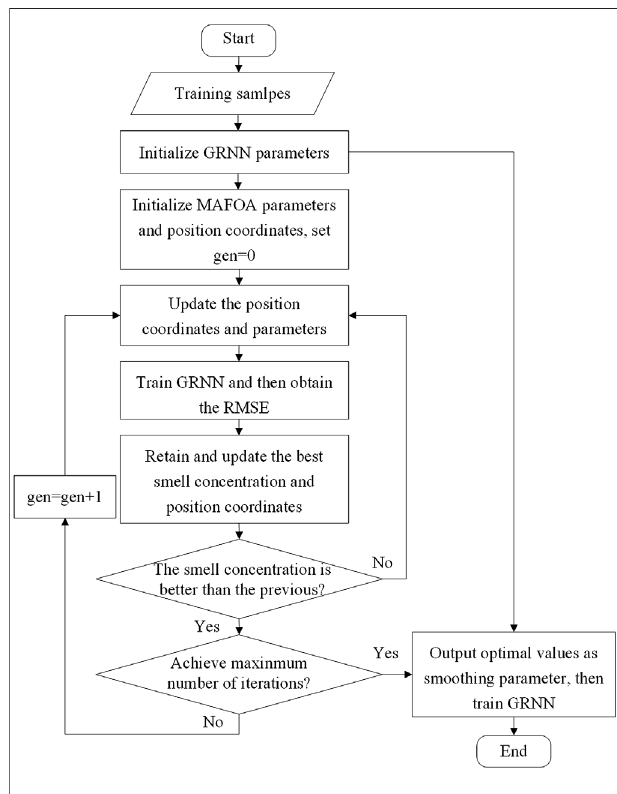
FIGURE 2 | Flowchart of the MAFOA-GRNN